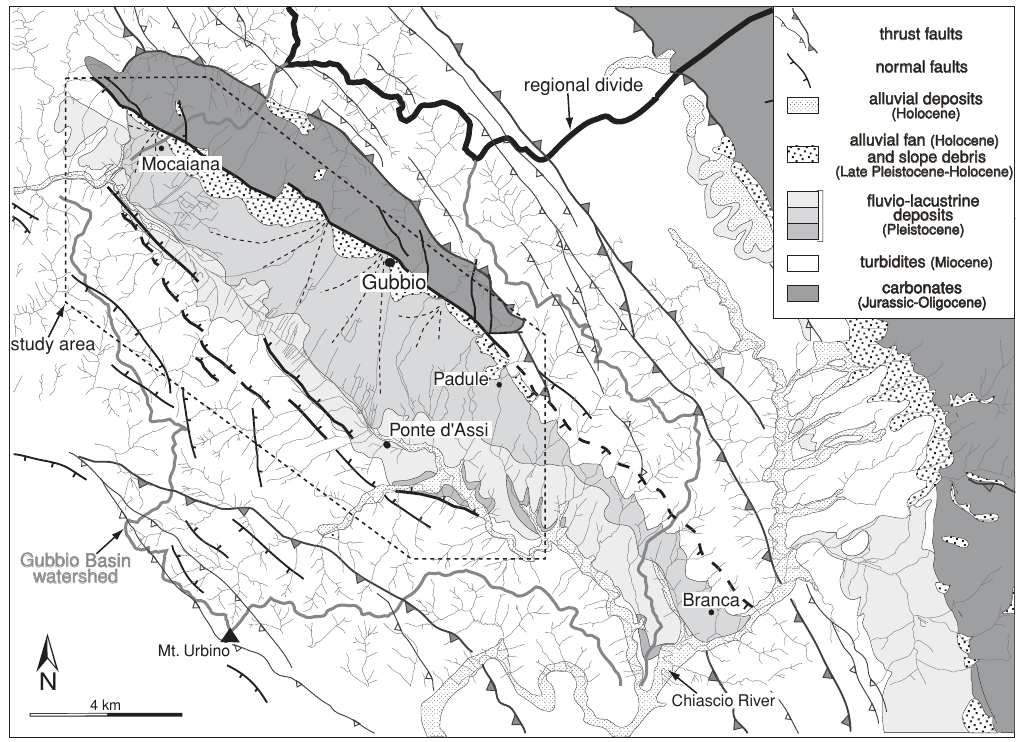
Fig. 2. Simplified geological map of the Gubbio Basin. Thick normal faults are discussed in this work (after Bonarelli et al. , 1952; Moretti and Perno, 1968; Menichetti and Pialli, 1986; Collettini, 2001,